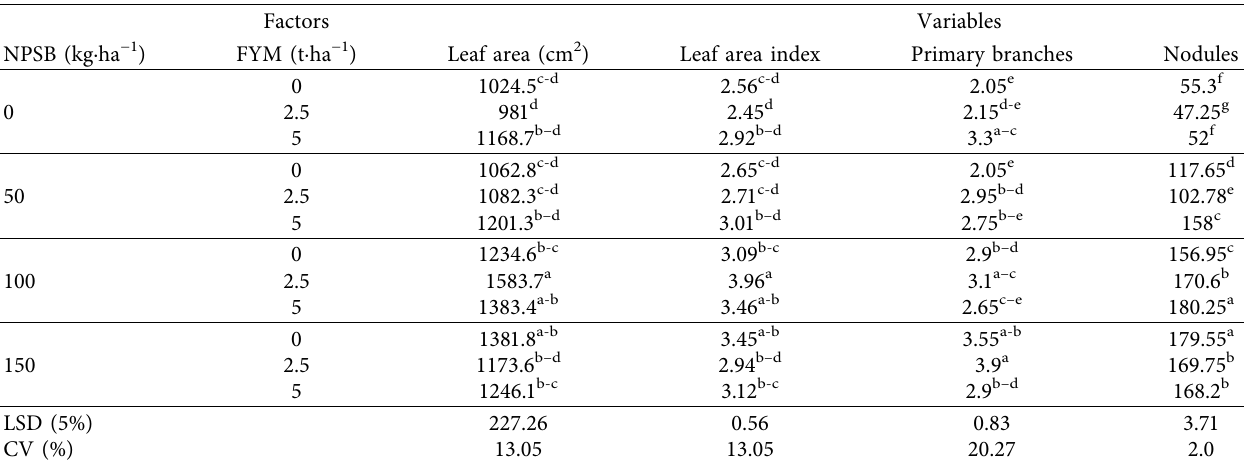
Table 5: Leaf area, leaf area index, number of primary branches, and number of total nodules per plant as afected by NPSB and FYM rates.